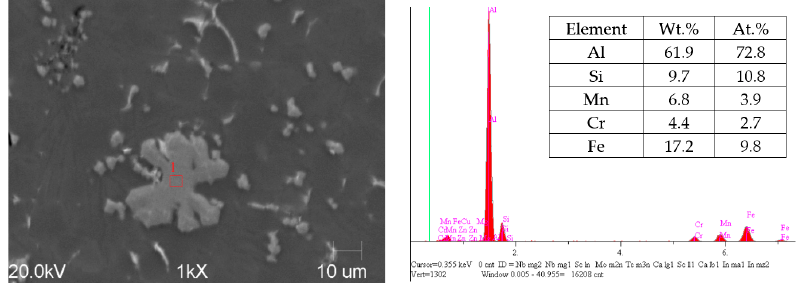
Figure 14. Microstructure of tested alloy in the casting with M series (Table 1)—area of wall thickness 6 mm with EDS analysis of iron-rich particle.